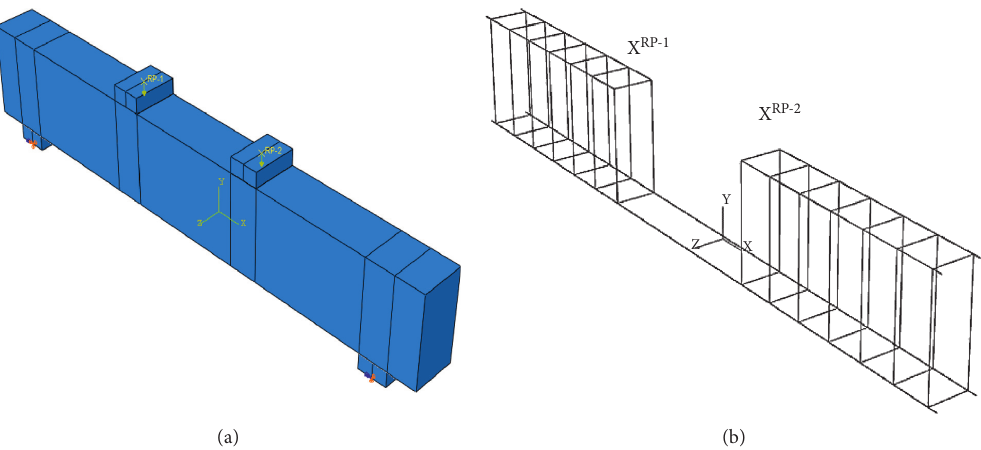
Figure 10: Finite element model of the simply supported RAC beam. (a) Beam model. (b) Steel skeleton model.